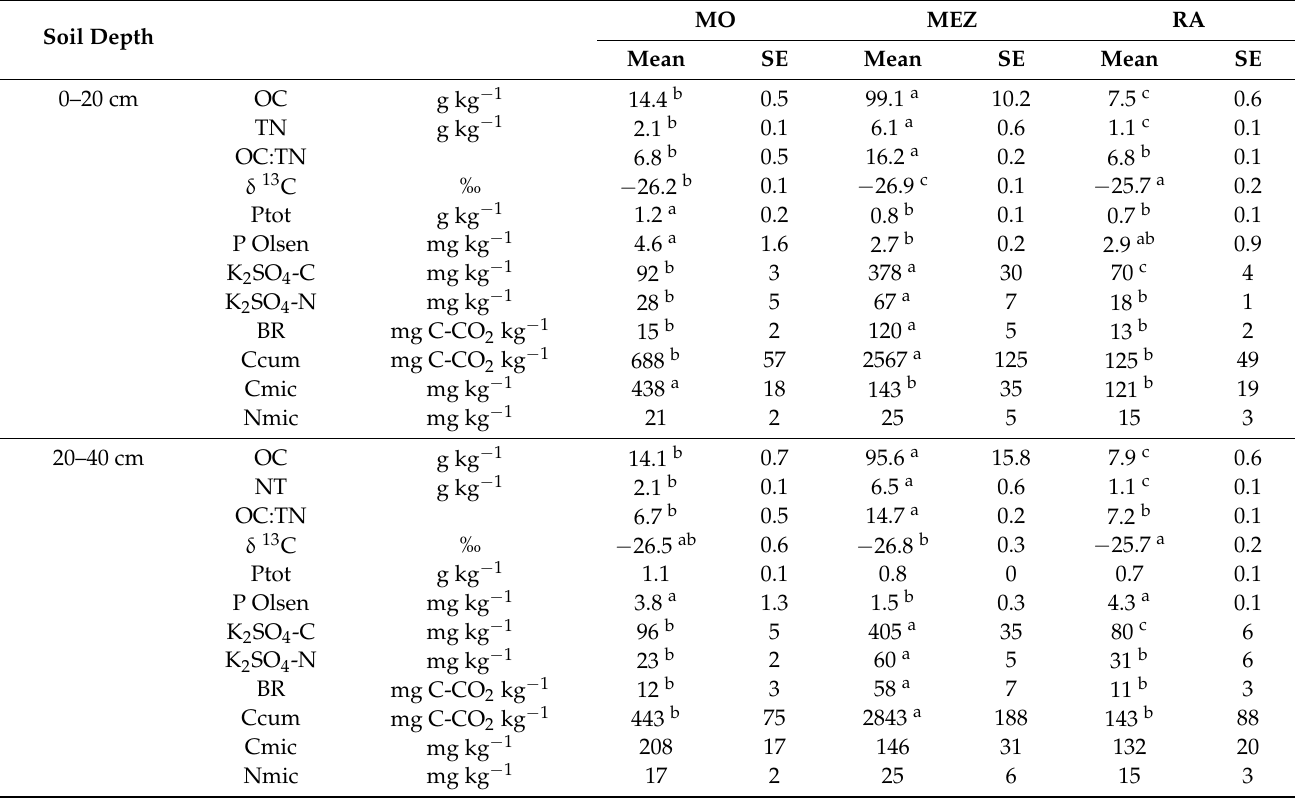
Table 2. Mean and standard error (SE) values of soil organic C (OC) and total N contents, C:N ratio, δ 13 C, total and available P contents (TP and POlsen, respectively), labile organic C and N contents (K 2 SO 4 -C and K 2 SO 4 -N, respectively), basal and cumulative respiration (BR and Ccum, respectively), microbial biomass C and N contents (Cmic and Nmic, respectively) in 0–20 and 20–40 cm soil layers of processing tomato fields located in Modena (MO), Ferrara (MEZ) and Ravenna (RA) provinces, Emilia Romagna Region, Italy. Different letters mean significant differences (Kruskal–Wallis test, p < 0.05) among sites within 0–20 and 20–40 cm soil